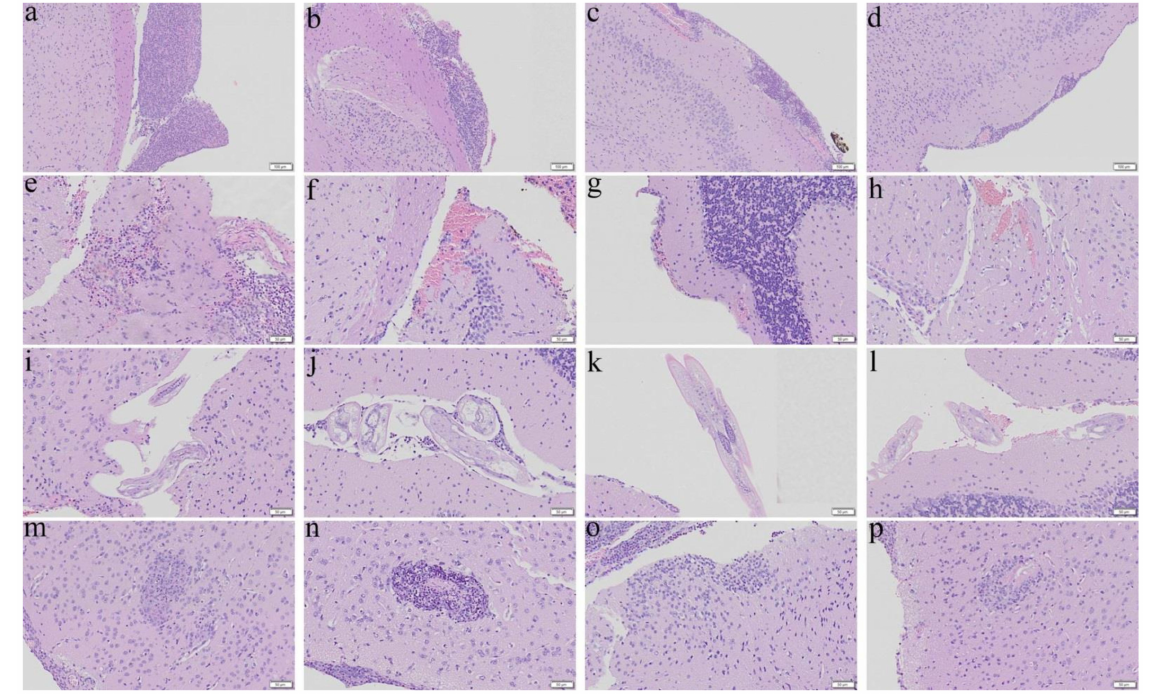
Figure 1. Representative photomicrographs showing meningitis, presence of worms, hemorrhage, and encephalitis in the cerebral parenchyma of the BALB/c mice infected with Angiostrongylus cantonensis treated from day 7 for 7 days. ( a , e , i , m ) Untreated mice. ( b , f , j , n ) Mice treated with albendazole alone. ( c , g , k , o ) Mice treated with dexamethasone alone.